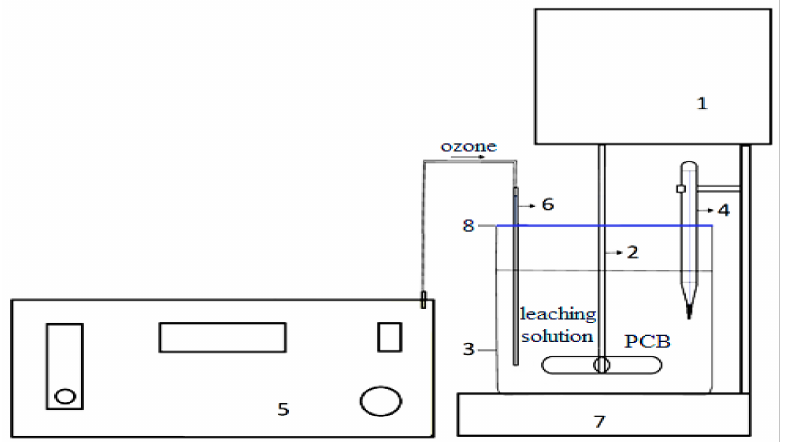
Figure 1. Scheme of leaching stand (1—mechanical agitator, 2—glass agitator, 3—glass beaker, 4— thermometer, 5—ozone generator, 6—ozone introduction, 7—heating plate, and 8—system